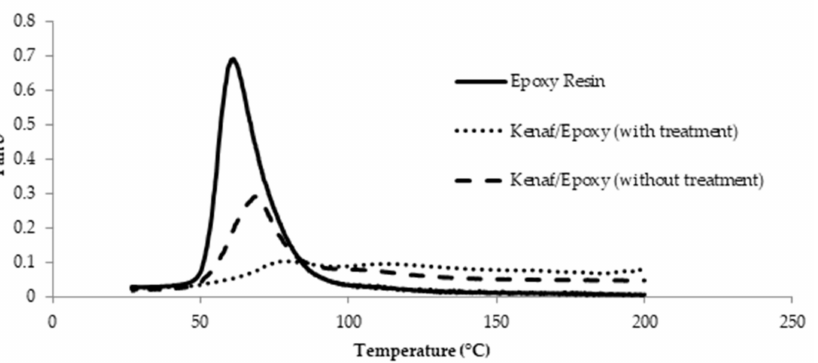
Figure 11. Damping factor (tan δ ) spectra for epoxy composite reinforced with untreated and treated kenaf fiber.